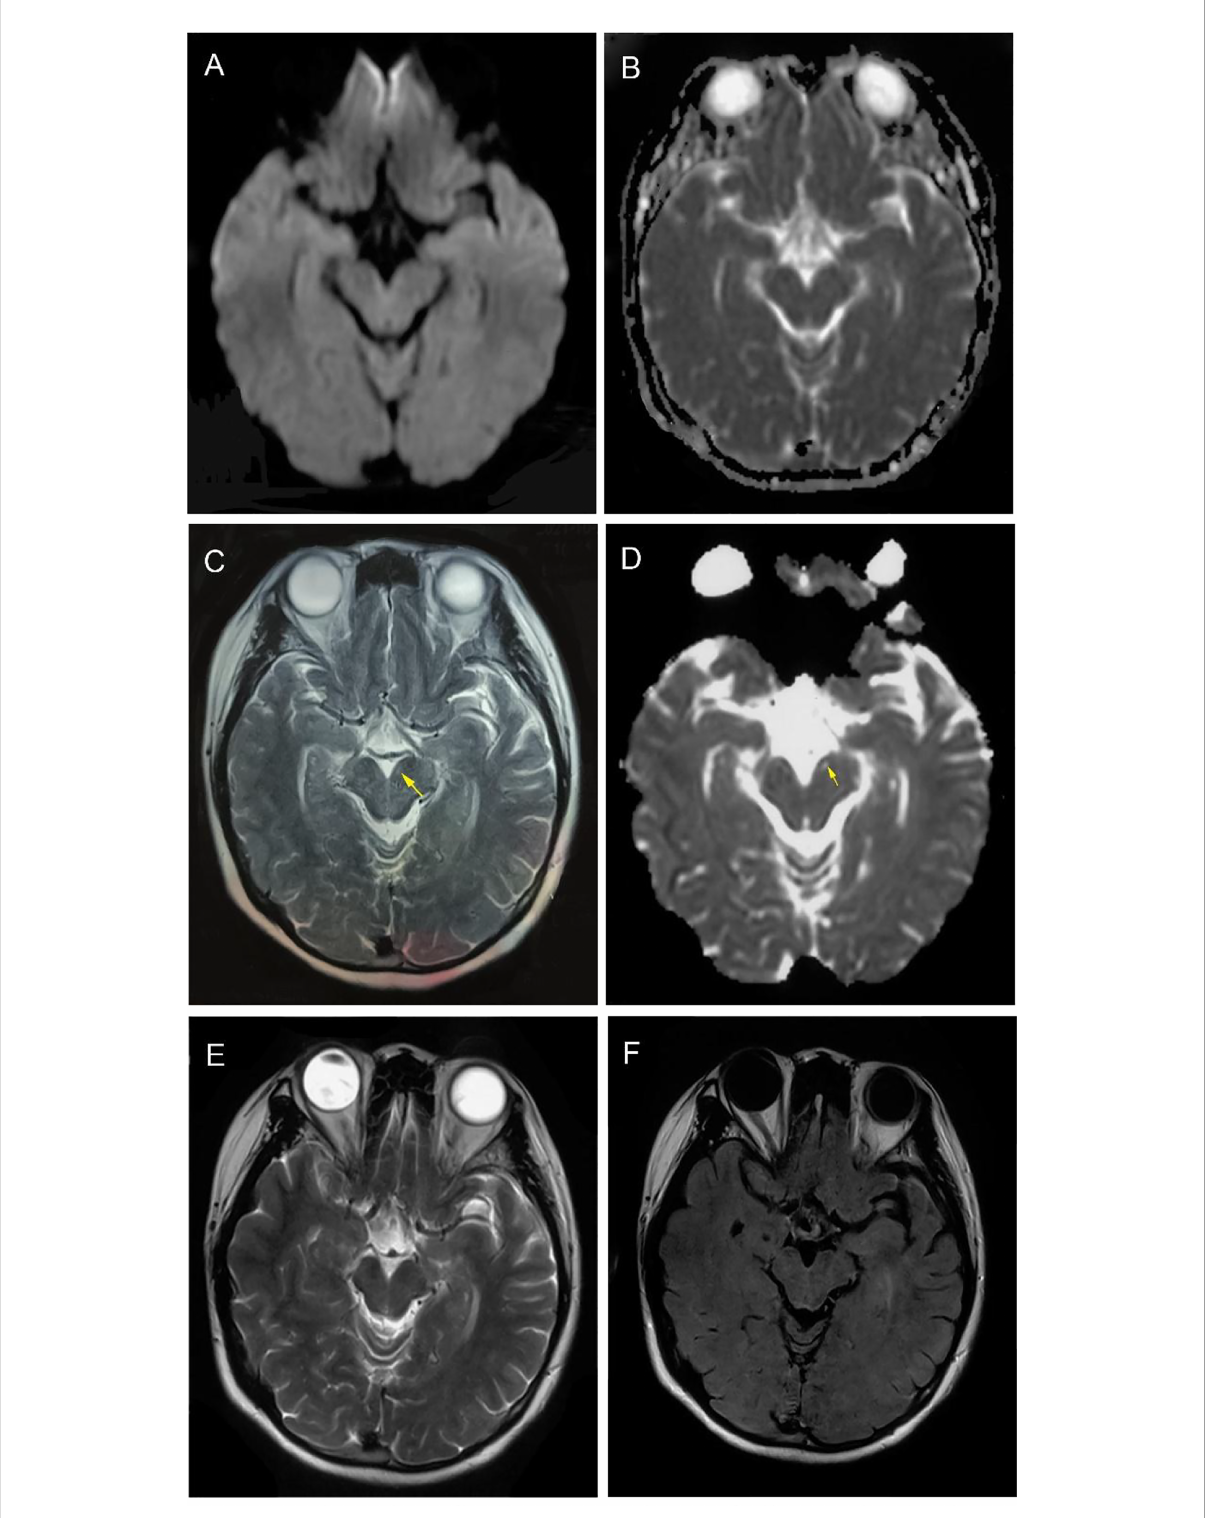
FIGURE 1 Magnetic resonance imaging fi ndings. At time of diagnosis, brain MRI DWI and ADC sequences (transverse) showed no suspicious signal alterations (A, B) . Four months after onset, T2 and ADC sequences showed obvious high signals on the left midbrain interpeduncular fossa (highlighted by arrows) (C, D) . One year later, T2 and T2- fl air sequences (transverse) showed midbrain lesions disappeared. (E, F)